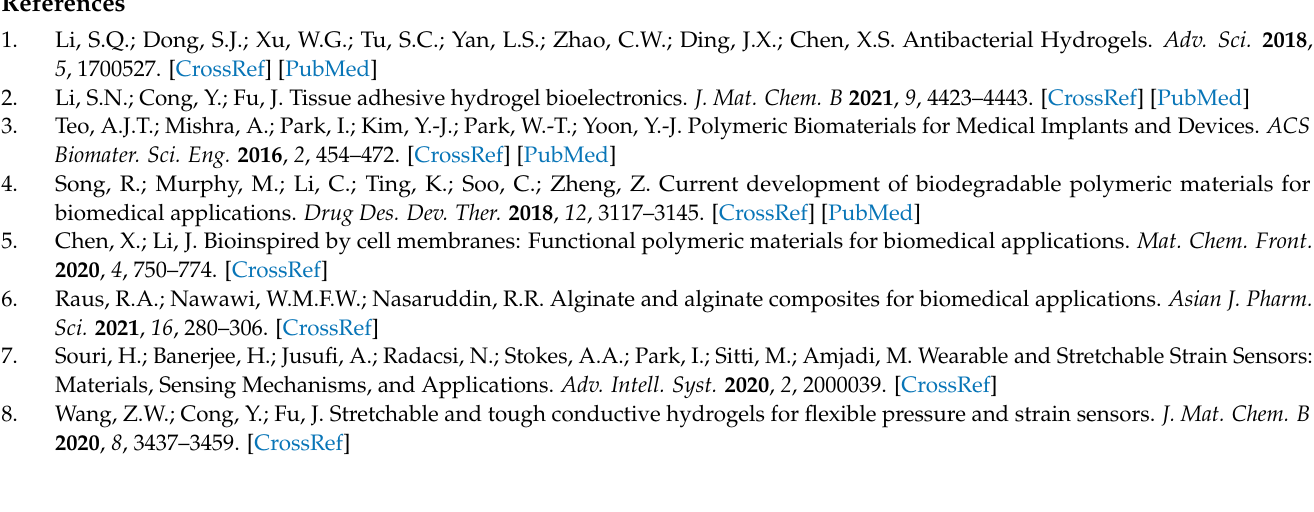
figure is represented the data of the control samples, the samples dehydrated under compressive and tensile stress. The bar with solid colors are the values for AH100-0 and the striped ones for AH50-50. Note that the same scale is used in the axes; Figure S4: Oscillatory frequency sweeps of the dehydrated alginate hydrogels. (a) AH100-0 and (b) AH50-50. Note that same scales are used in both axes; Figure S5: (a) Sketch with the directions of the stresses applied to the alginate hydrogels during the SCDPs. (b,c) sketch and picture, respectively, of the device used in the dehydration process under tensile stress. (d) Sketch of the dehydration process under compressive stress; Figure S6: SEM images of the alginate hydrogels studied. (a,b) polymeric structure of AH100-0 and AH50-50 after the SCDP under compressive stress (side view), respectively. (c,d) polymeric structure of AH100-0 and AH50-50 after the SCDP under compressive stress (top view), respectively. The compressive stress in all cases was applied during 30 minutes. Scale bars correspond to 1 µ m; Figure S7: (a) Sketch of the mold and the soft magnetic actuator. (b) Approximation used for the calculation of the angle of the magnetic beam of the actuator; Figure S8: Angle vs. Magnetic field intensity for all the magnetic particles concentration and dehydration of the actuator. FD: First dehydration; SD: Second Dehydration; I.: Increasing; D.: Decreasing. Note that same scales are used in both axes; Table S1: Two samples t -test with a significance level of 0.05 and null hypothesis mean1-mean2=0 for the magnitudes from the uniaxial tensile tests measured parallel to the direction of the tensile stress applied during the SCDPs. Column a: equal variance is assumed. Column b: equal variance is not assumed; Table S2: Two samples t -test with a significance level of 0.05 and null hypothesis mean1-mean2=0 for the magnitudes from the oscillatory shear tests. Column a: equal variance is assumed. Column b: equal variance is not assumed; Table S3: Two samples t -test with a significance level of 0.05 and null hypothesis mean1-mean2=0 for the magnitudes from the uniaxial tensile tests measured perpendicularly to the direction of the tensile stress applied during the SCDPs. Column a: equal variance is assumed. Column b: equal variance is not